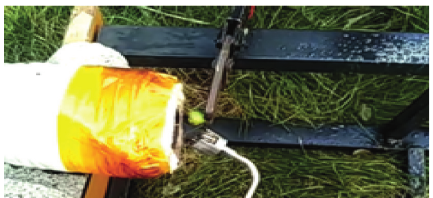
Figure 5: Experiments of PE heat decomposition.